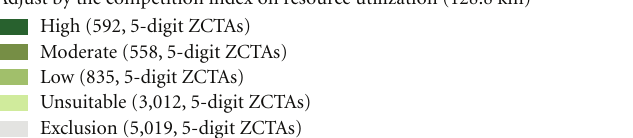
Figure 6: Opportunity zones identified by the combined landscape suitability and competition indices in the 13-state study region.